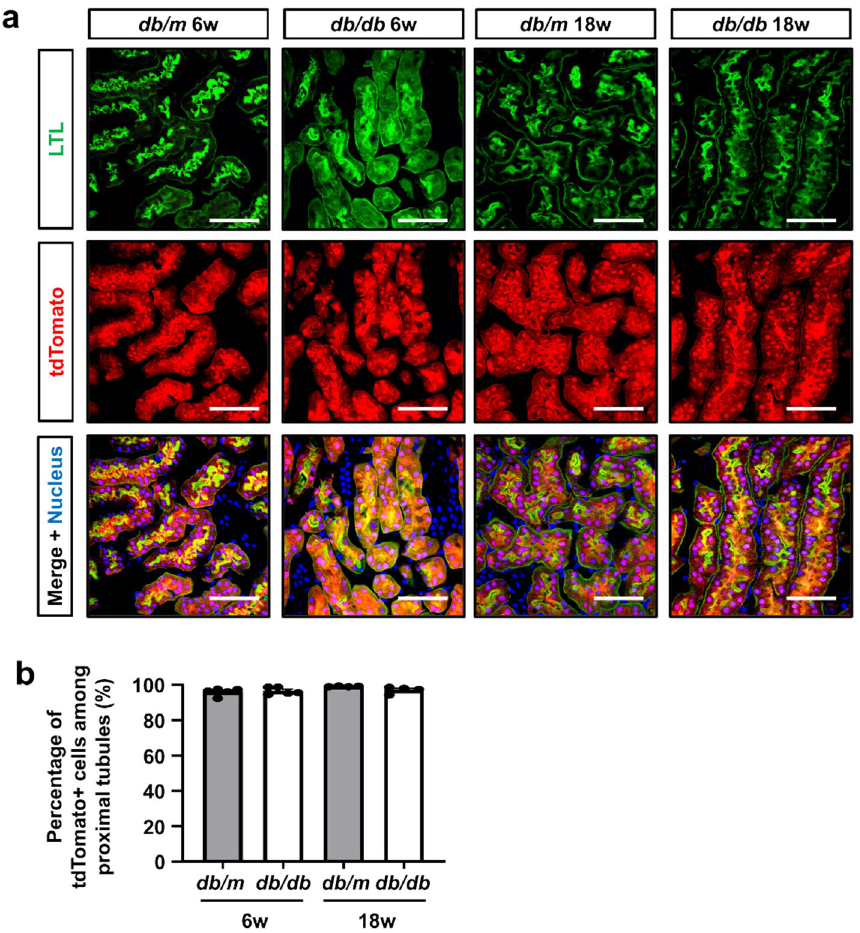
Figure 2. No participation of cells of extratubular origin in proximal tubules of db/db mice. ( a ) Representative images of fluorescence of LTL and tdTomato in kidney sections. Bar = 50 μm. ( b ) Quantification of the percentage of tdTomato+ cells among LTL + cells. There was no dilution of labeling of the tdTomato reporter in proximal tubules of db/db